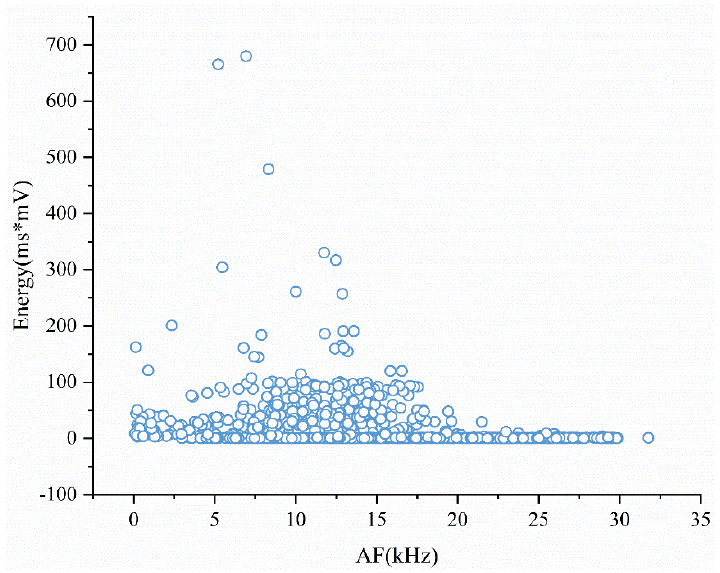
Figure 24. Average frequency-energy correlation diagram of noise signal of Caihong Bridge.